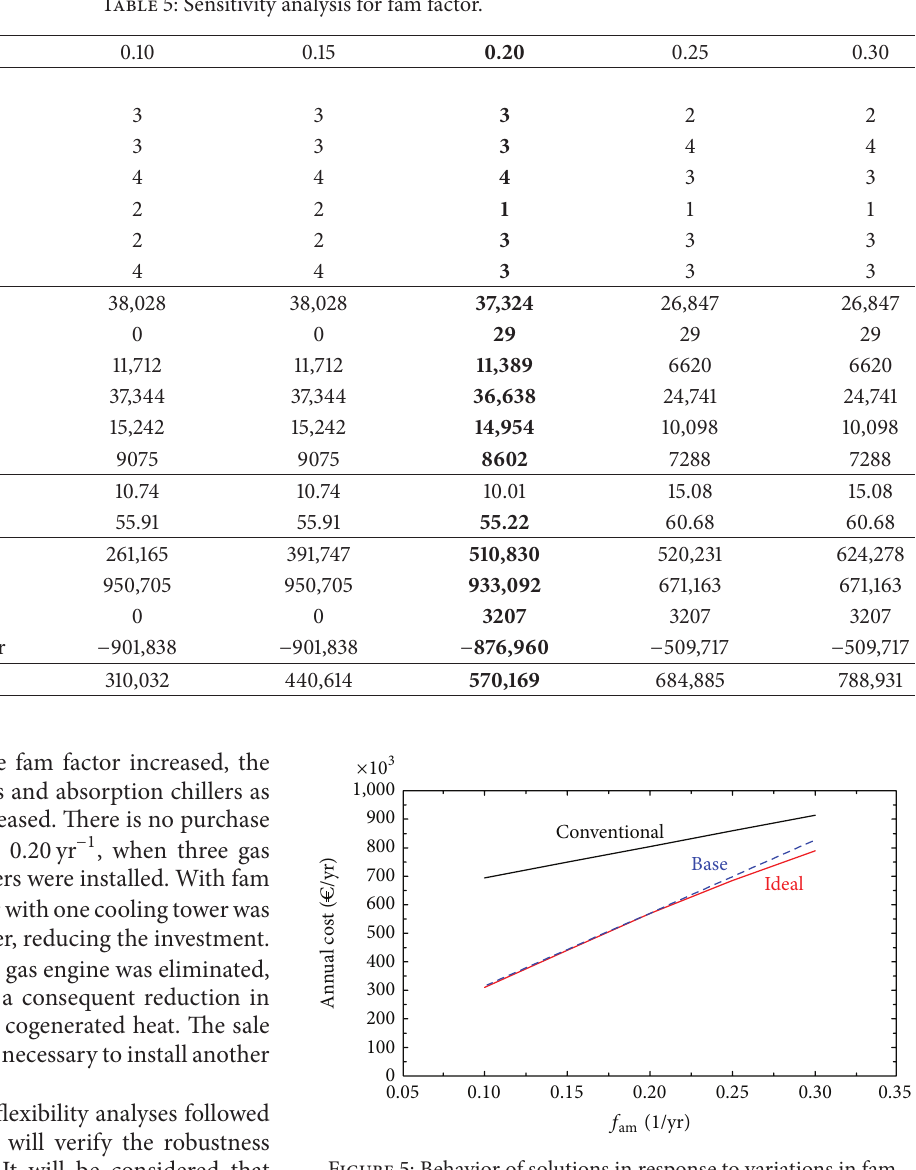
Figure 5: Behavior of solutions in response to variations in